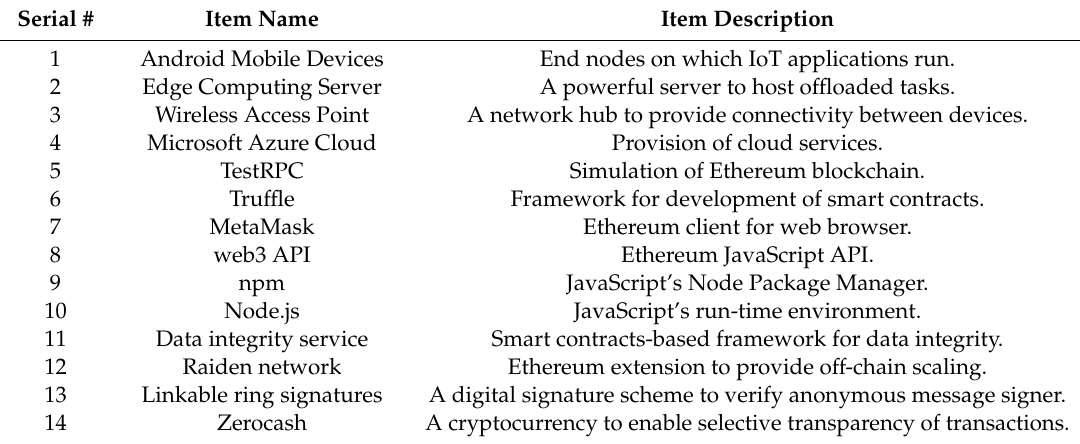
Table 2. List of tools, equipment and technologies for prototype development and